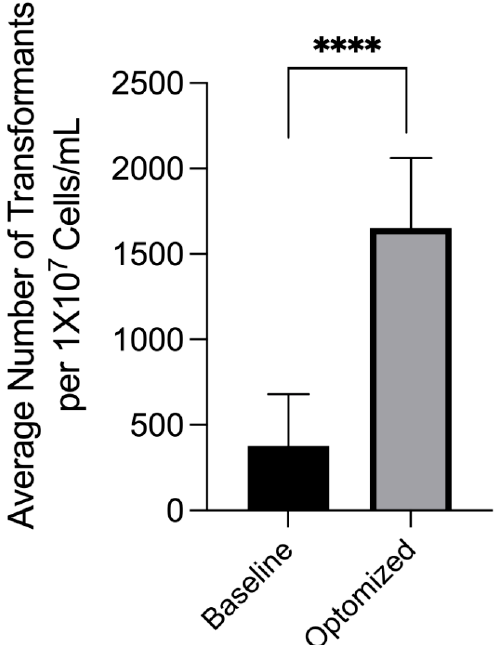
Figure 7. Comparison of optimized conditions to standard baseline conditions. Using the data above, optimal conditions were chosen and compared to the standard protocol. Transformation frequency improved roughly 4-fold. Brackets with **** above bars indicate groups with statistically significant differences. **** = p ≤ 0.0001.